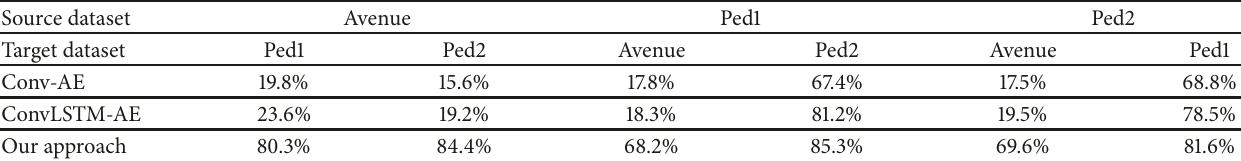
Table 3: Performance of the different approaches across datasets (frame-level